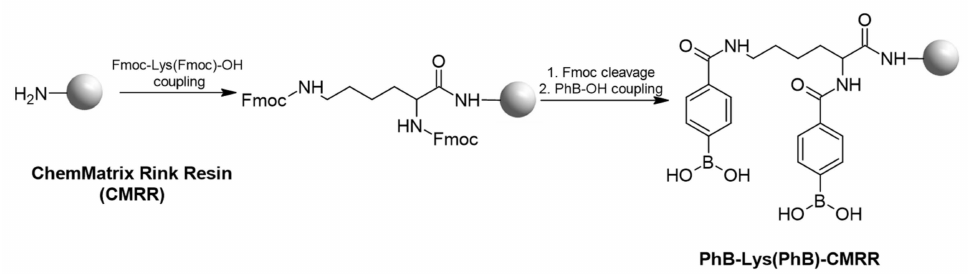
Figure 5. Synthesis of the functionalized resin PhB-Lys(PhB)-ChemMatrix ® Rink (scheme based on the work of Kijewska et al.